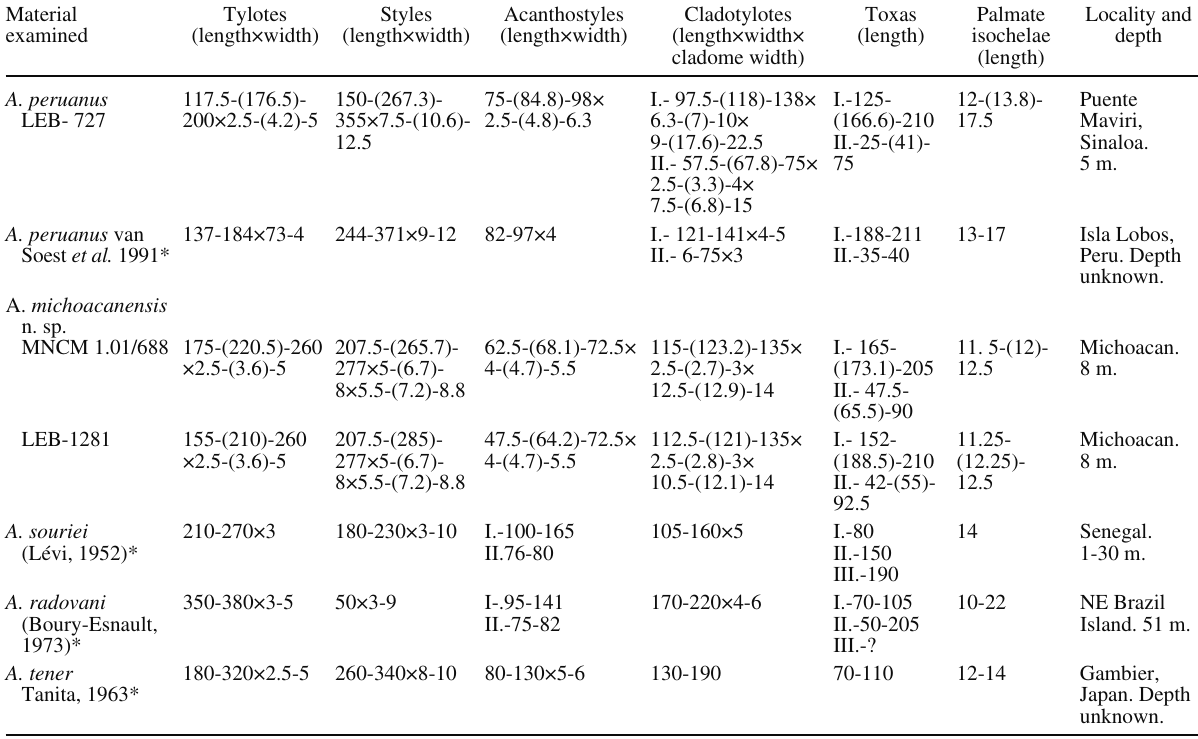
Table 2. – Comparative table data of the Acarnus species of the “souriei” group from the Mexican Pacific and other specific worldwide localities. Values are expressed in minimum-average-maximum (μm). *Spicule measurements from the original description. Material Tylotes Styles Acanthostyles Cladotylotes Toxas Palmate Locality and examined (length×width) (length×width) (length×width) (length×width× (length) isochelae cladome width) (length)